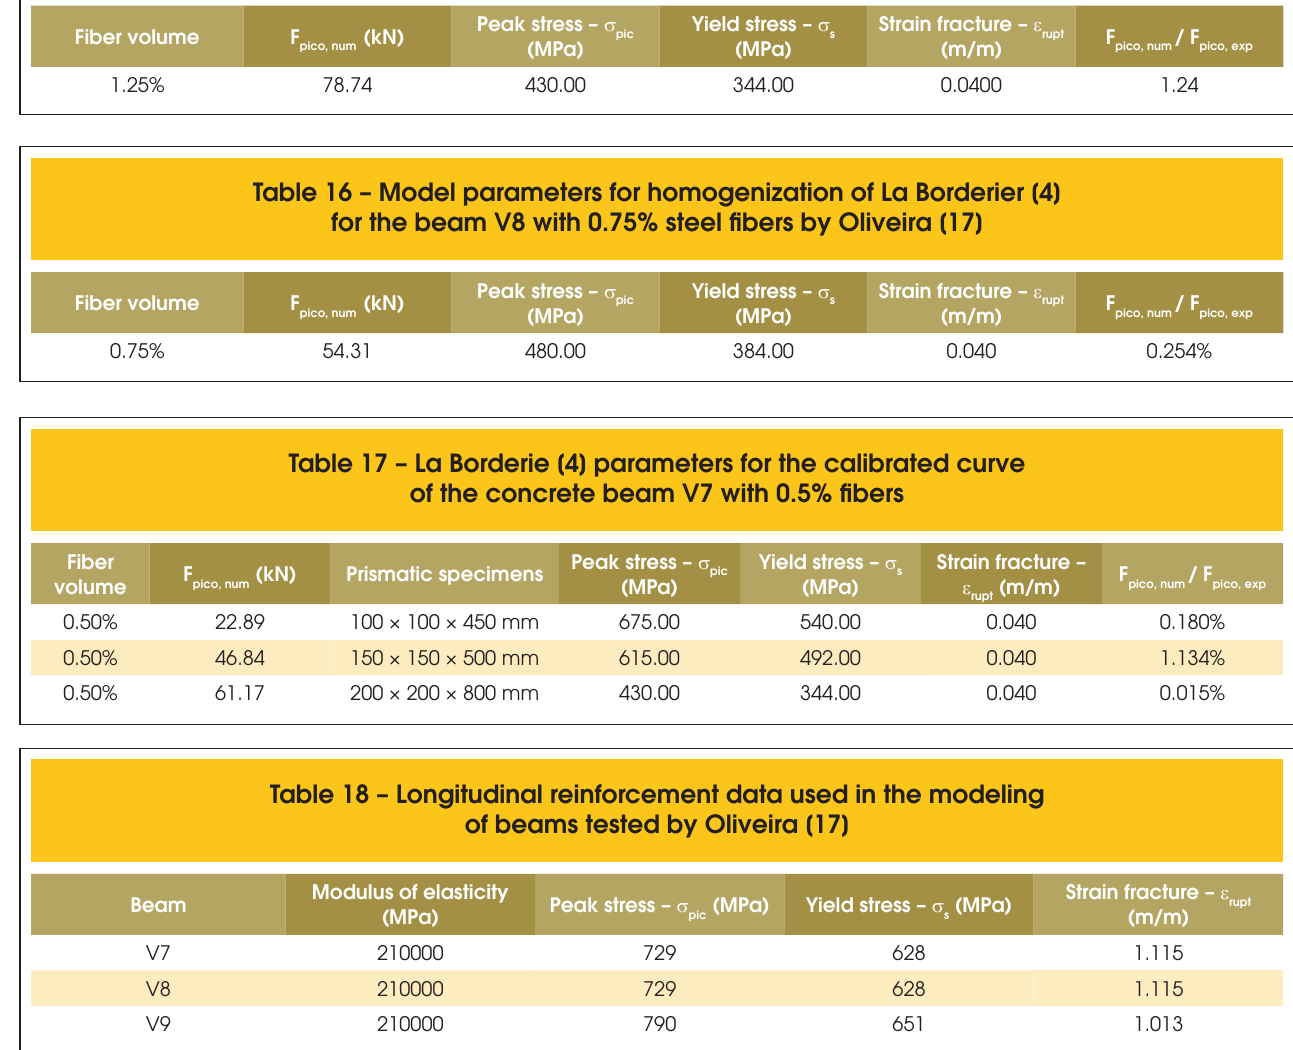
Table 15 – Model parameters for homogenization of La Borderier [4] for concrete with 1.25% fibers – Example III